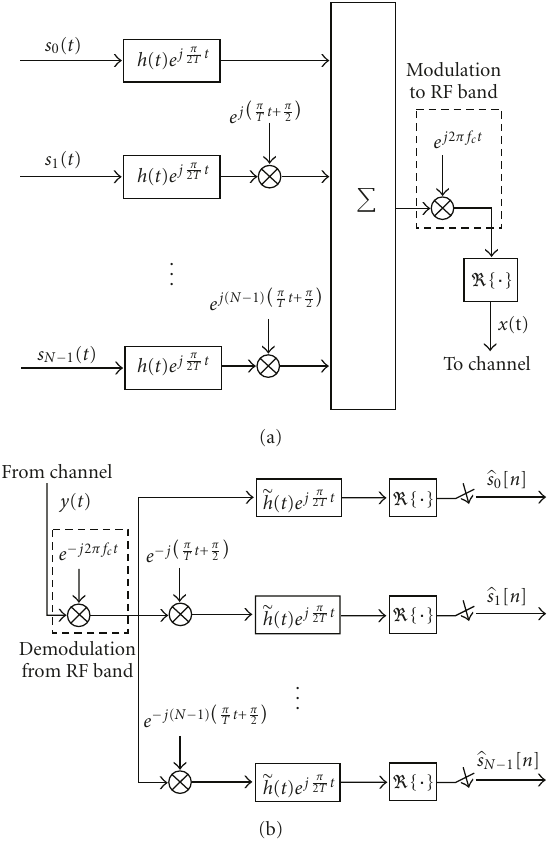
Figure 2: Block diagram of a CMT